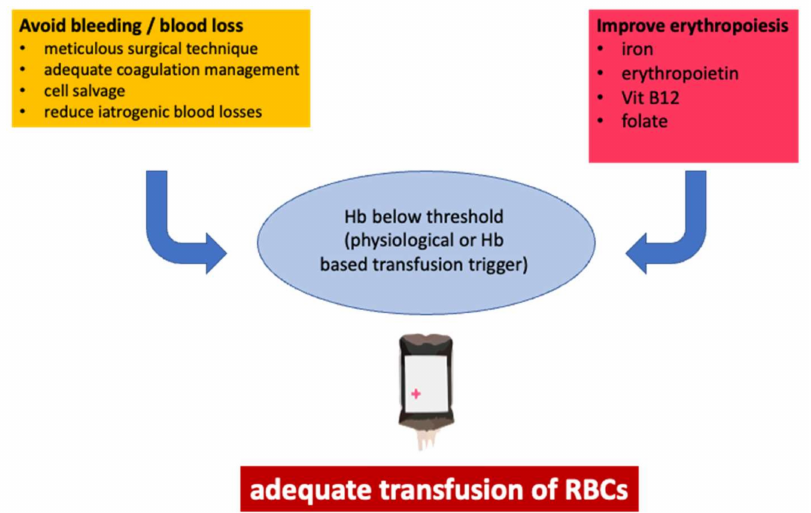
Figure 3. Usually, PBM is depicted as a three-pillar model, which initiates the idea that all three pillars are equally important. However, there is a clear hierarchy in single measures. The avoidance of bleeding and the improvement of erythropoiesis might help, but the Hb concentration remains